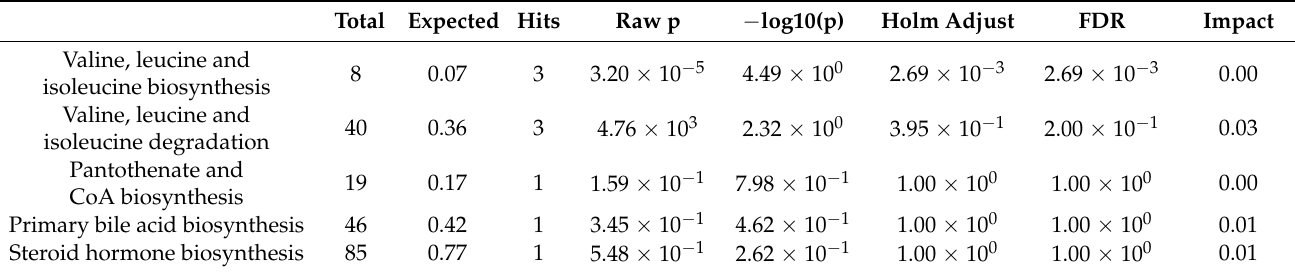
Table 4. Detailed results from the pathway analysis for male patients. From the table, the “Total” in the table is the total number of compounds in the pathway; the “Hits” is the actually matched number from the user uploaded data; the “Raw p” is the original p value calculated from the enrichment analysis; the “Holm p” is the p value adjusted by Holm-Bonferroni method; the “FDR p” is the p value adjusted using false discovery rate; the “Impact” is the pathway impact value calculated from pathway topology